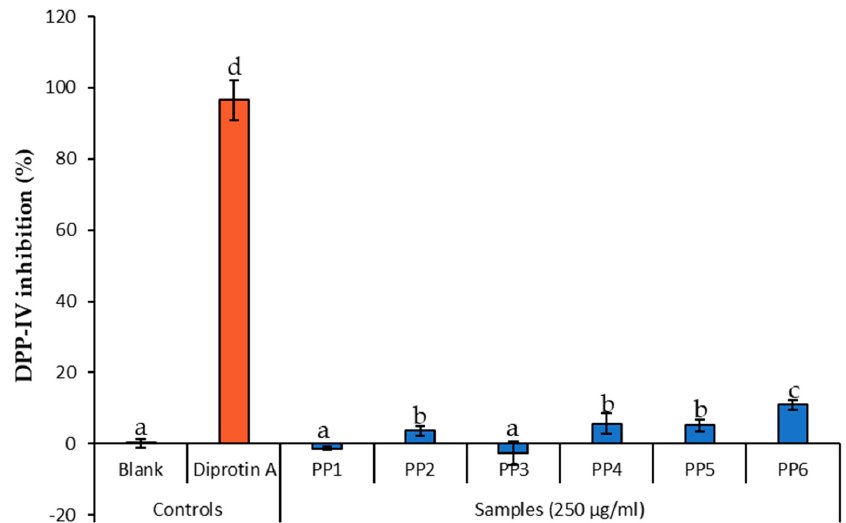
Figure 3. The inhibition of dipeptidyl peptidase-IV enzyme by di ff erent fractions from the methanolic extract of L. tetragona . The values are expressed as mean ± SD (n = 5). Bars with di ff erent letters are significantly di ff erent ( p <